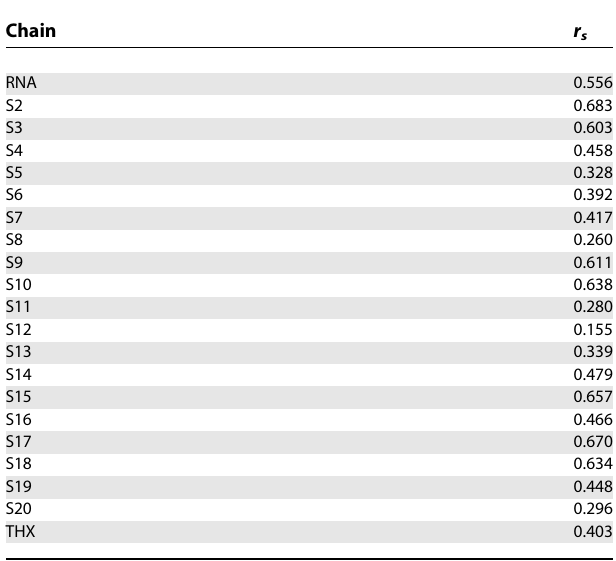
Table 1. Comparing Computed versus Experimental B-Factors with a Ranking Measure (Spearman’s r s ) Chain RNA